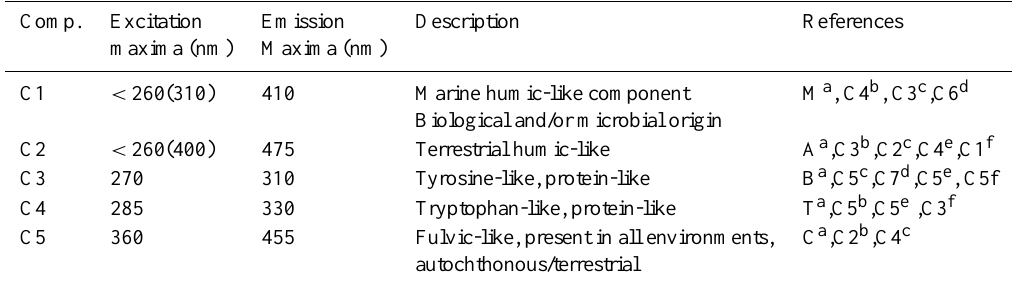
Table 2. Description of the five components identified by PARAFAC analysis of EEMs fluorescence data in this study and their comparison with previously identified components.